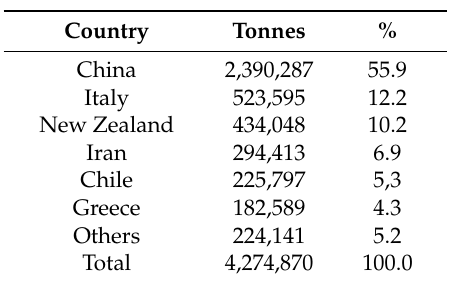
Table 2. Kiwi fruit production by Country in 2016 (Source